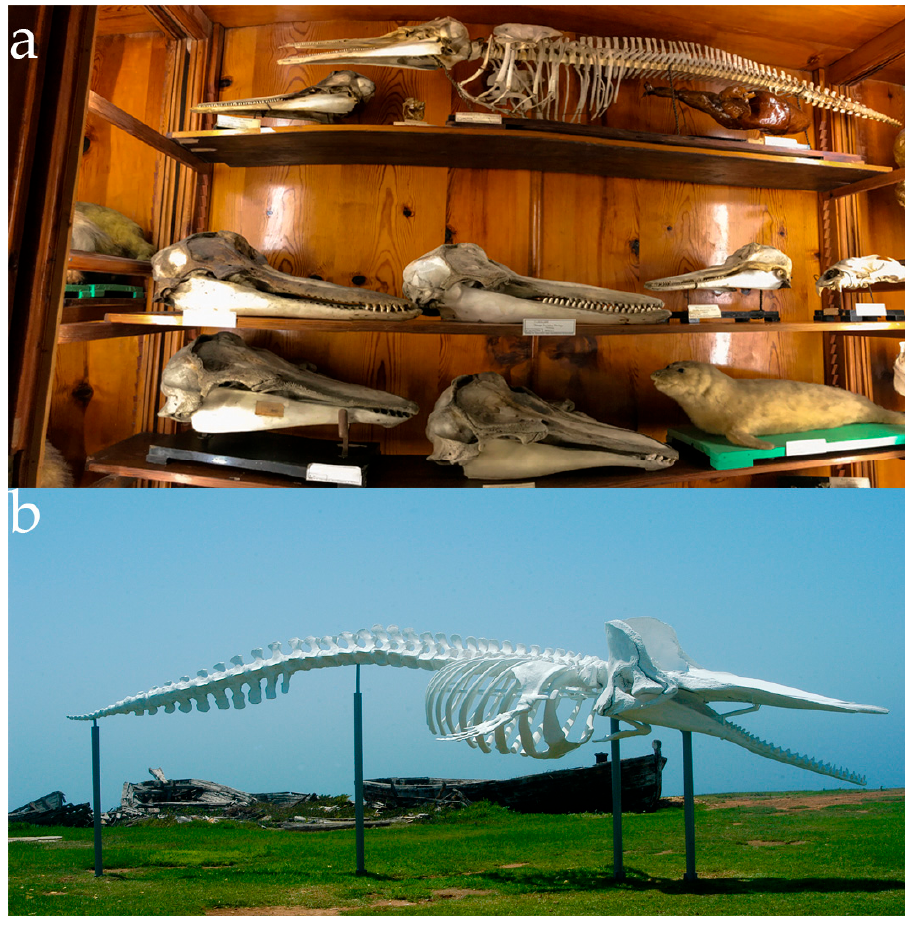
Figure 6. Examples of Sicilian cetological collections. ( a ) A view of the exhibition at the Museum of Zoology “P. Doderlein” of the University of Palermo. From above to below: Delphinus delphis skull, partial skeleton and anatomy apparatus; two Tursiops truncatus skulls, and a Stenella coeruleoalba skull; two Grampus griseus skulls. ( b ) The Physeter macrocephalus skeleton at the Institute of Anthropic Impact and Sustainability in marine Environment (CNR-IAS) section of Capo Granitola, Campobello di Mazara (Tp) (photos ©Andrea Calascibetta and © Gaspare